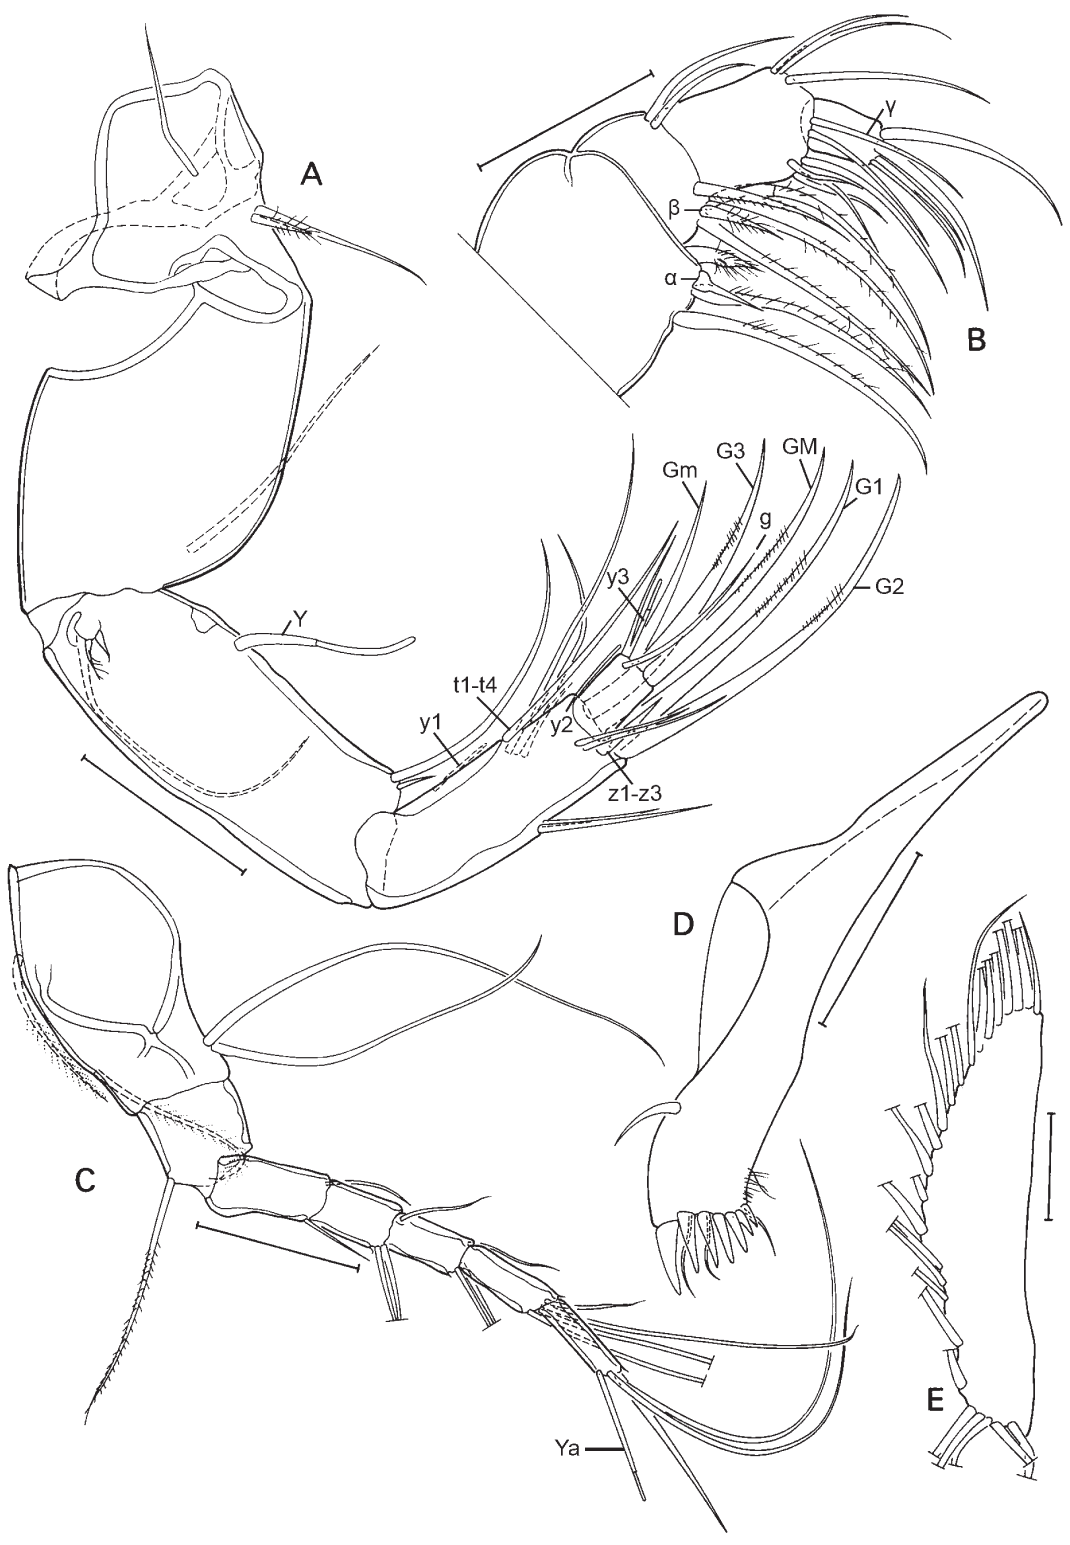
Fig. 5. Candobrasilopsis rochai gen. nov. sp. nov., limbs (♀). A . A2 (MZUSP.28110). B . Md palp (OC.3292). C . A1 (OC.3292). D . Md, coxal plate (MZUSP.28109). E . Mx1, respiratory plate (MZUSP.28116). Scale bars: A-E = 50